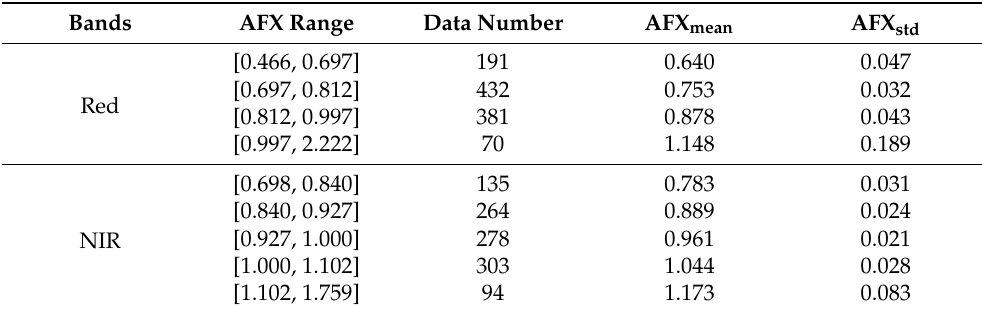
Table 8. AFX ranges for the BRDF archetypes that were derived from the 1066 sets of daily accumu- lated high-quality multiangle